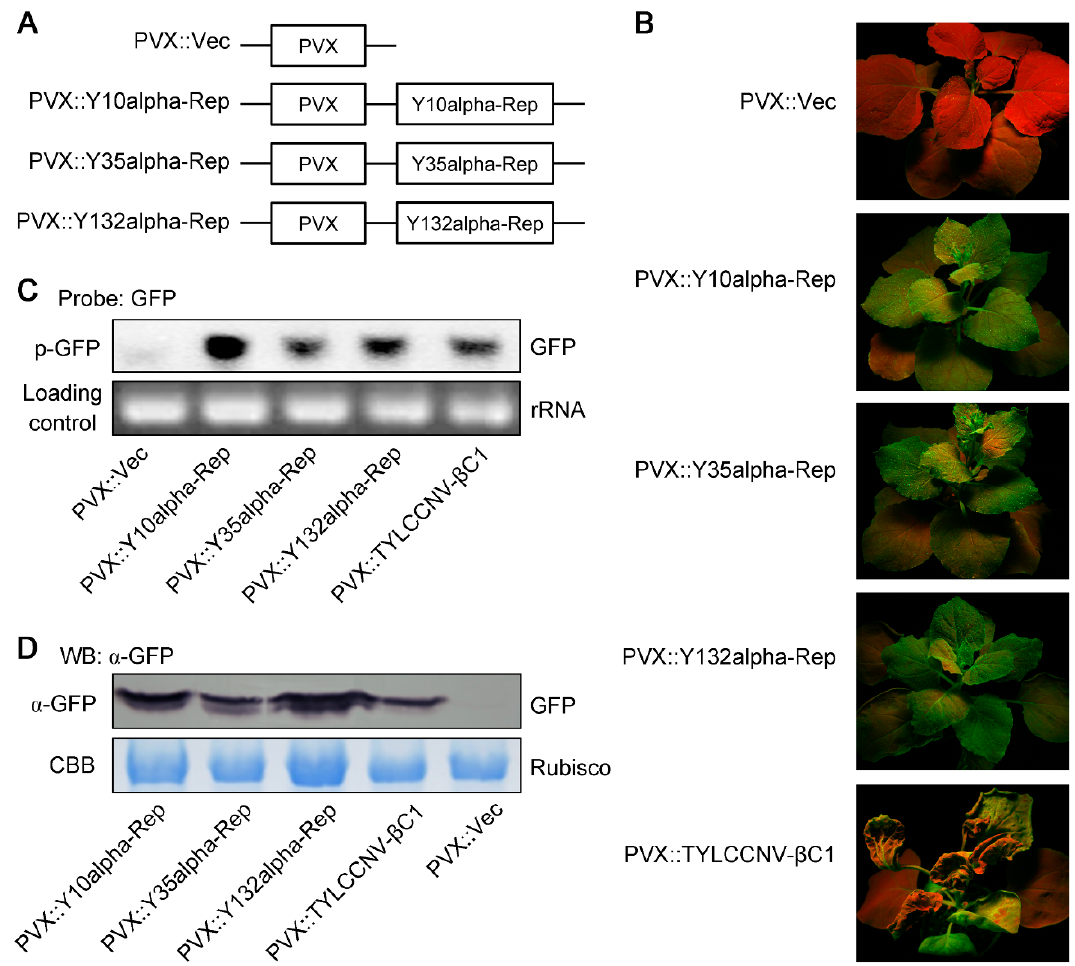
Figure 4. Alpha-Reps suppress the transcriptional gene silencing (TGS) of GFP. ( A ) Schematic diagram showing the constructs used in the GFP TGS assay in panel B. The ORFs of Y10alpha-Rep, Y35alpha-Rep, and Y132alpha-Rep were cloned into the PVX, to be used for transient expression. An empty PVX vector (PVX::Vec) was used as the negative control. ( B ) Transgenic N. benthamiana 16-TGS plants were agroinfiltrated with PVX::Y10alpha-Rep, PVX::Y35alpha-Rep, or PVX::Y132alpha-Rep, and the plants were photographed under UV light at 14 dpi. 16-TGS plants agroinoculated with PVX::Vec and PVX::TYLCCNV-βC1 were used as negative and positive controls, respectively. ( C ) Northern blot analysis of GFP mRNA accumulation in agroinfiltrated leaf patches is shown in panel B. An ethidium bromide-stained gel shown below the blots provides an RNA-loading control. ( D ) Western blot (WB) assay of GFP accumulation in agroinfiltrated leaf patches shown in panel B. CBB staining of the large subunit of Rubisco was used as a loading control. For ( B – D ) the experiments were repeated three times with similar results.